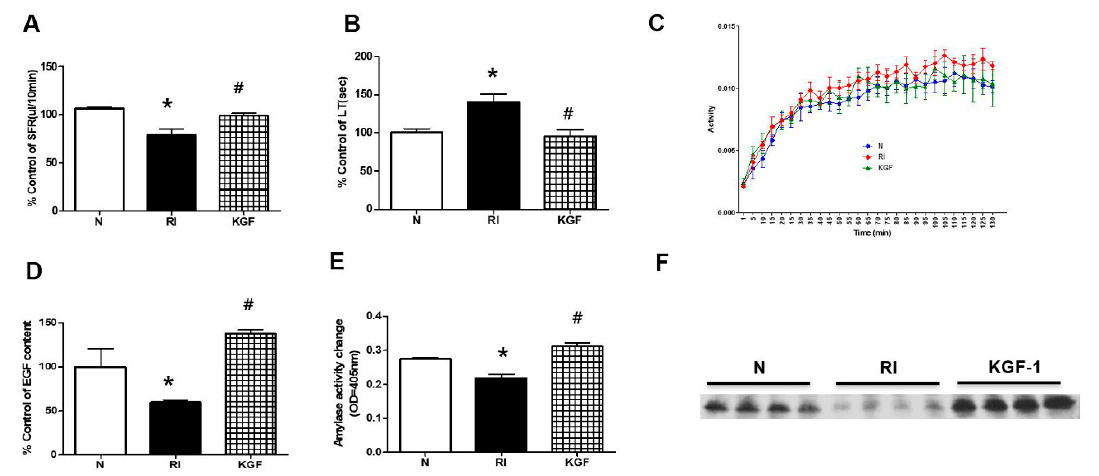
Figure 2. Evaluation of salivary function after RI+KGF-1 treatment. ( A ) Salivary flow rates (SFRs) and ( B ) lag times (LTs). SFRs were greater in the RI+KGF-1 group than in the RI group and LTs were shorter in the RI+KGF-1 group. ( C ) 99mc Tc pertechnetate excretion was lower in the RI group than in